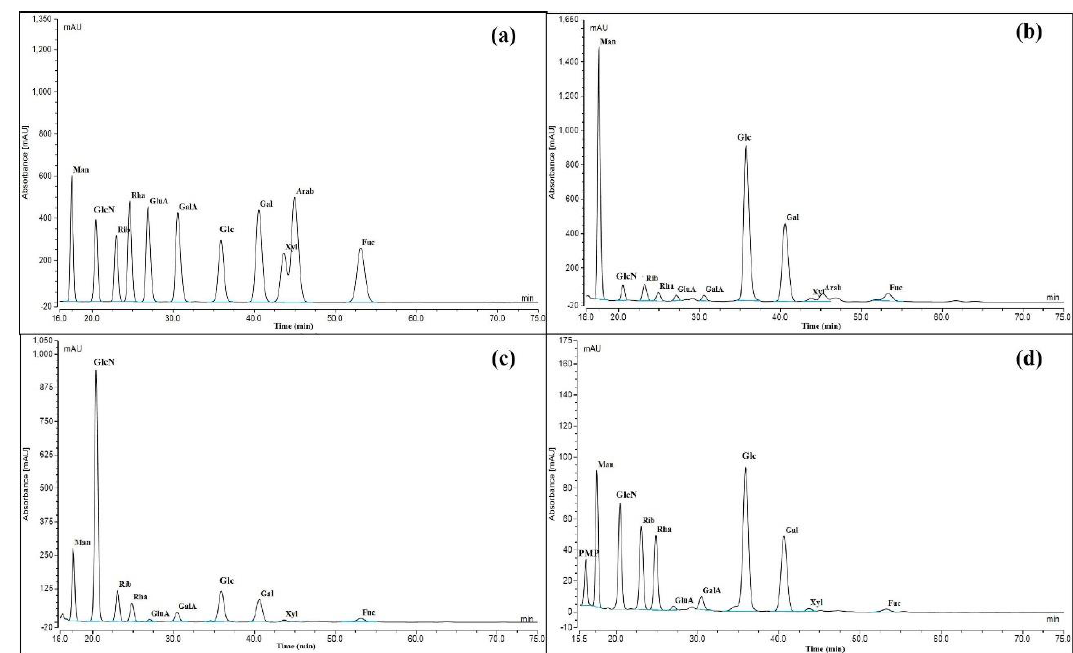
Figure 3. High performance liquid chromatography of standard monosaccharides ( a ), CMP-1 ( b ), CMP-2 ( c ) and CMP-3 ( d ). (Mannose: Man, glucosamine: GlcN, ribose: Rib, rhamnose: Rha, glucuronic acid: GlcA, galacturonic acid: GalA, glucose: Glc, galactose: Gal, xylose: Xyl, arabinose: Ara, fucose: Fuc). Table 1. The molar ratios of monosaccharide composition of CMP-1, CMP-2 and CMP-3. Samples